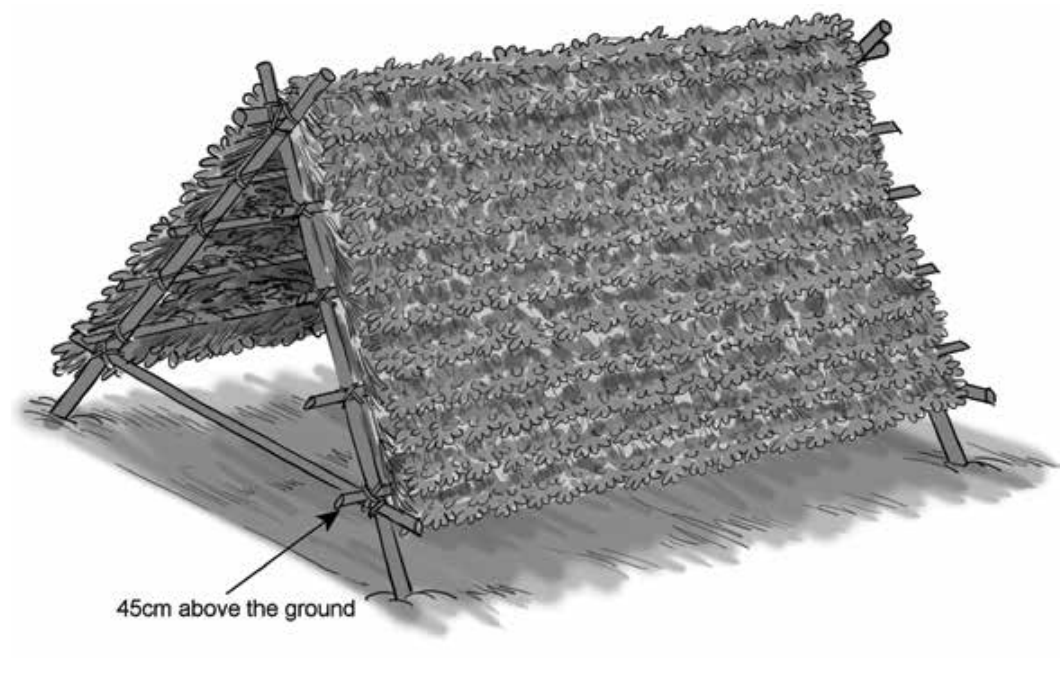
Figure 6: A-frame iv. Wooden or steel rack: This is a simple rectangular rack with one or more shelves, with the lowest shelf 45 centimetres off the ground. Either wooden (Figure 7) or steel frames can be used depending on availability. The rack can be positioned so that the groundnuts are shaded from direct sun. Racks can also be stored inside structures, including houses. Pods dried on racks which are not protected from the rain by a shelter should be covered or taken indoors during wet